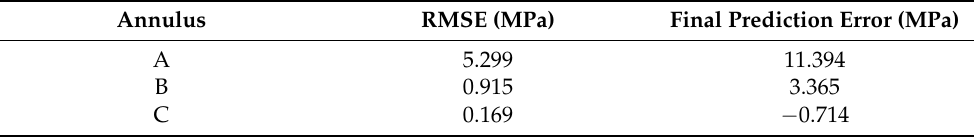
Table 8. The error analysis of calculated results without consideration of casing